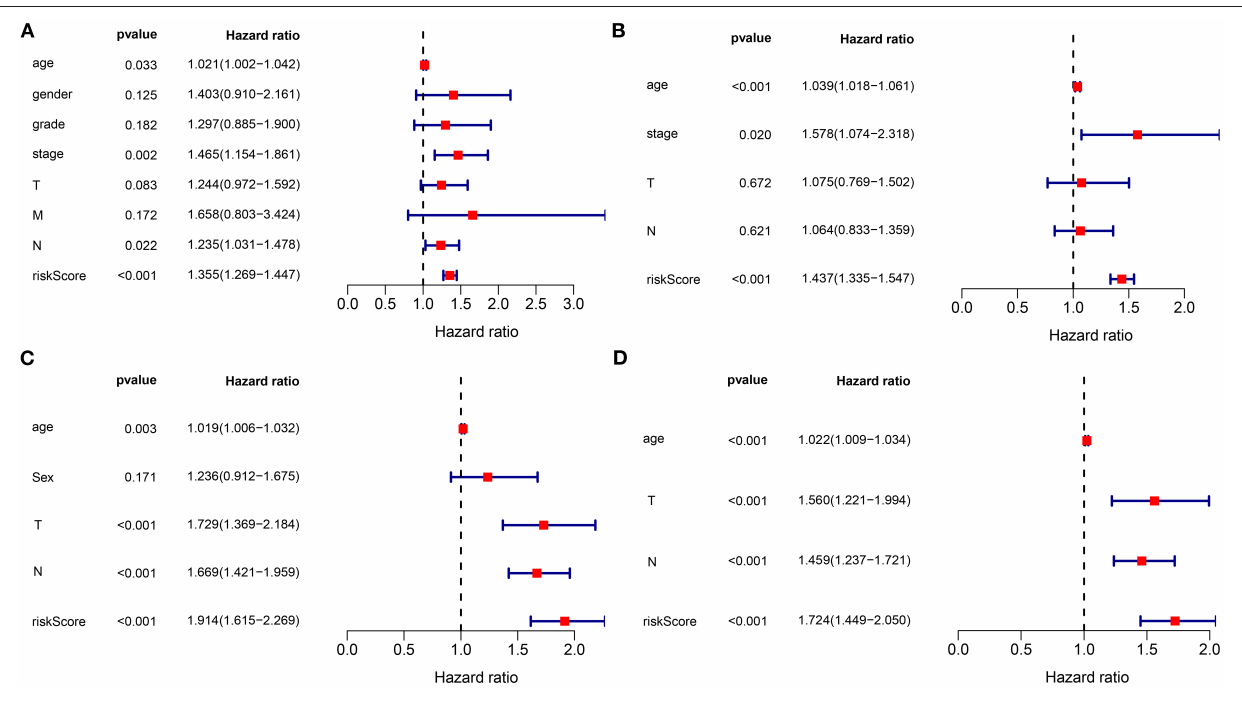
FIGURE 3 | The signature as an independent risk factor of gastric cancer. (A) Univariate and (B) multivariate Cox regression analyses of age, gender, grade, stage, TNM, as well as signature for gastric cancer in the training set. (C) Univariate and (D) multivariate Cox regression analyses for age, sex, T, N, and risk score for gastric cancer in the verification